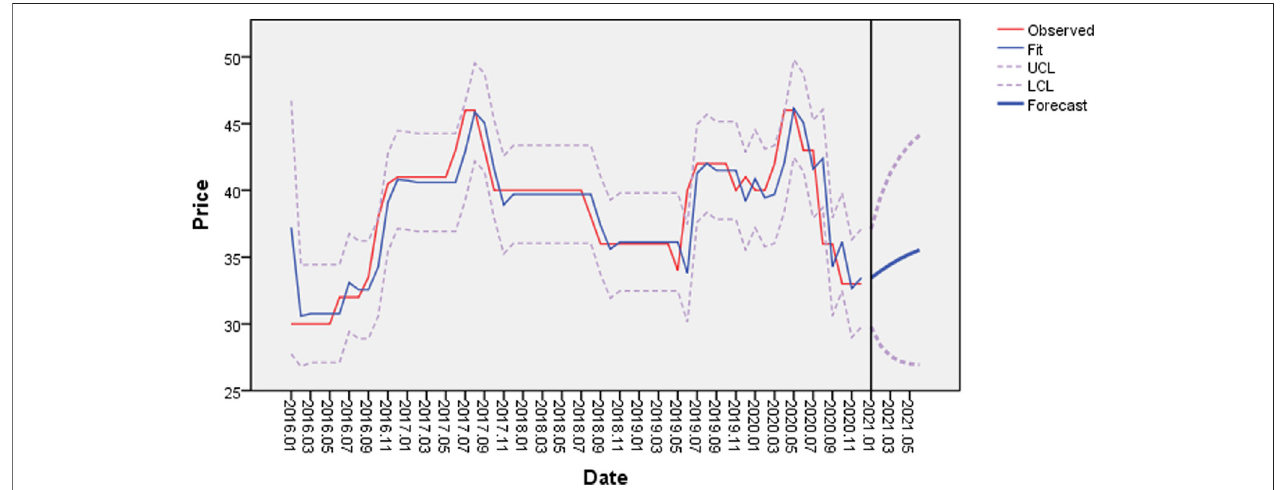
FIGURE 7 | GR price forecast